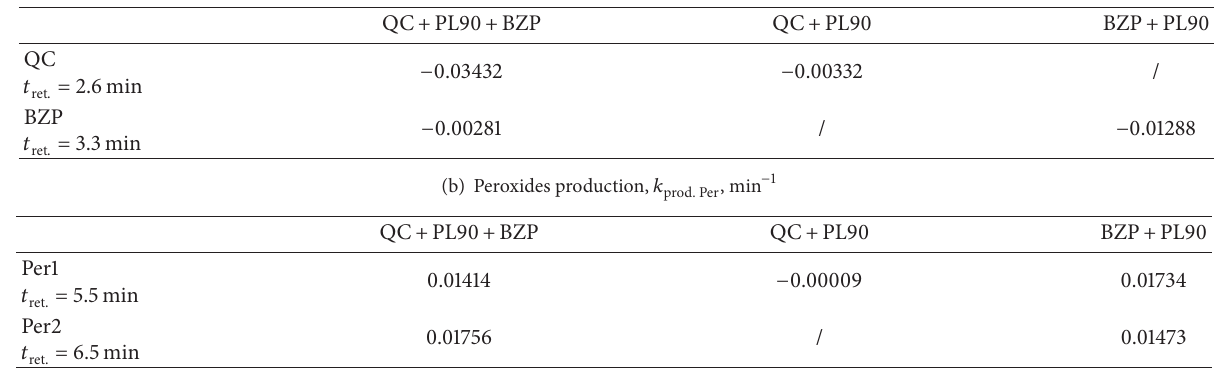
Table1:(a)Rateconstantsfordegradationofquercetin(QC)andbenzophenone(BZP)(min − 1 )obtainedfromtheslopesofthe1storderlinear = 𝑓 ( 𝑡 ), representing proportional decrease of QC and BZP concentrations as a result of the increasing UV-B irradiation plots, ln 𝑃 371/250nm irr . presents integrated areas of QC and BZP peaks, from the HPLC chromatograms (shown in Figures 2(a) and 3(a)) recorded periods. 𝑃 371/250nm at 371 and 250 nm, respectively. (b) Rate constants for the two peroxides formation, obtained from the slopes of the 1st order linear plot, ln 𝑃 = 𝑓 ( 𝑡 ), representing proportional increase of the two peroxides concentrations as a result of the increasing UV-B irradiation periods. 234nm irr . 𝑃 presents integrated areas of the peroxides peaks (Per1 𝑡 = 5.5min, Per2 𝑡 = 6.5min), from the HPLC chromatograms (shown in 234nm ret . ret . Figure 4(a)) recorded at